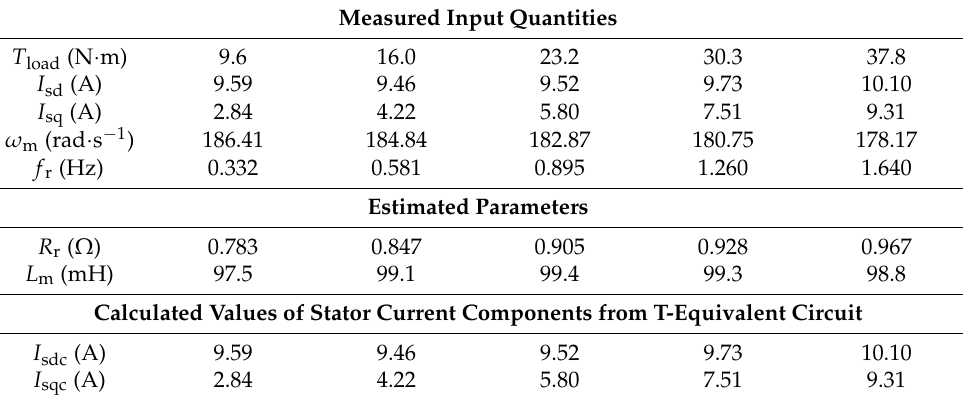
Table 4. Measurement at f s = 30 Hz ( ω s = 188.50 rad · s − 1 ) and V sq = 195 V.